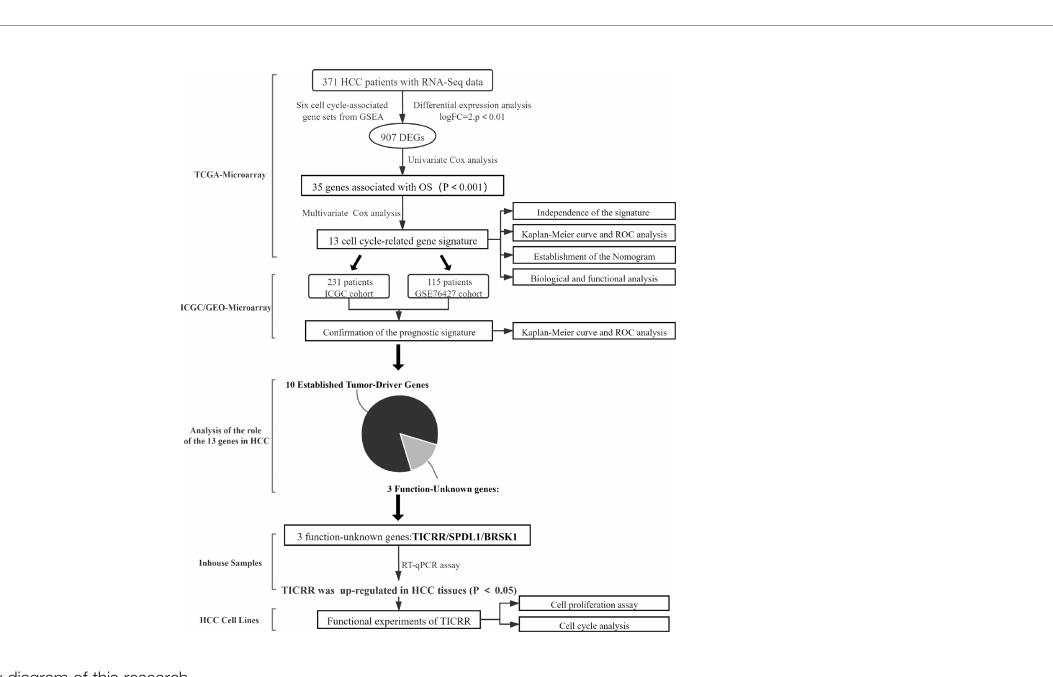
FIGURE 12 | A work fl ow diagram of this